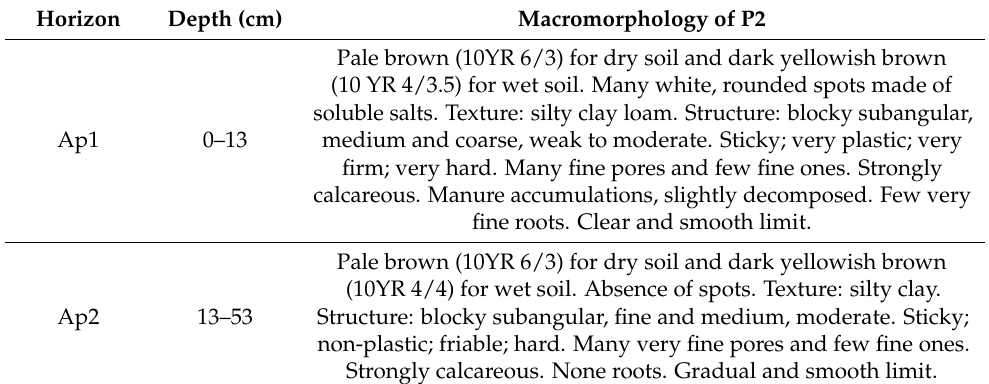
Table A3. Macromorphological description of profile 2